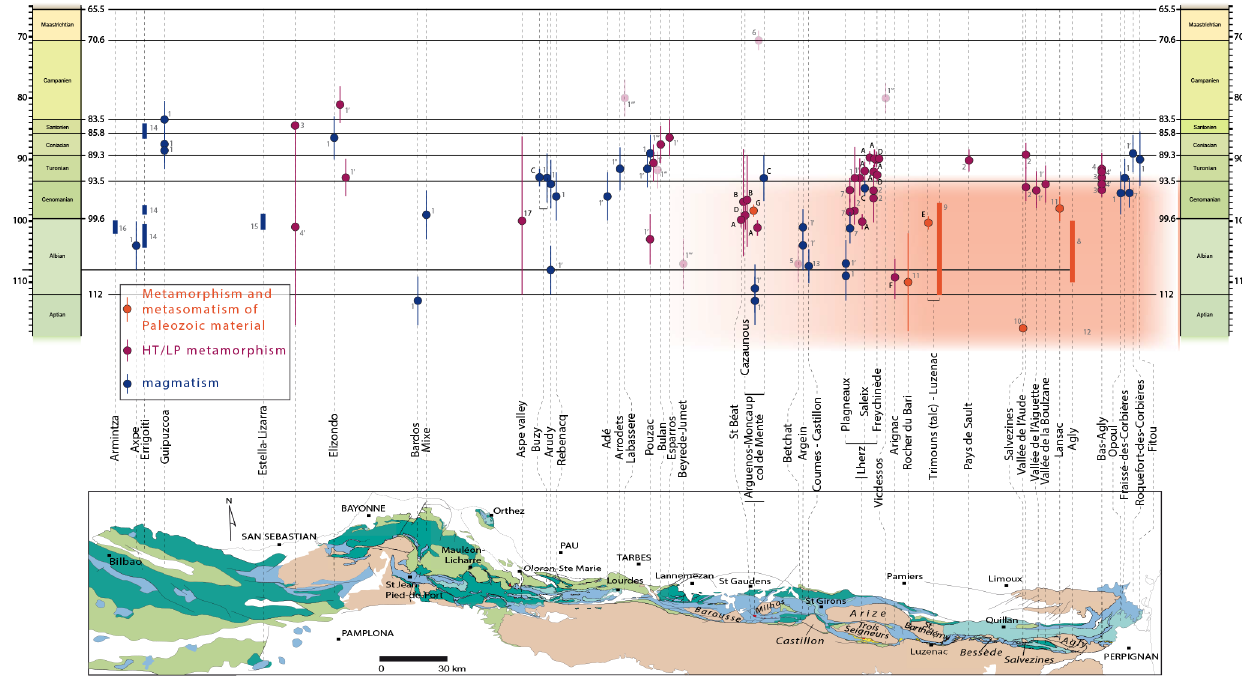
Figure 3. Compilation of the age and localization of the Cretaceous metamorphism and magmatism, modified and updated from